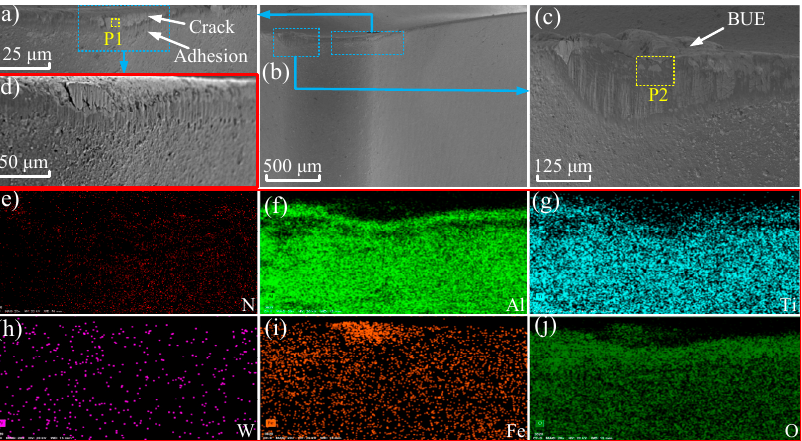
Figure 17. ( a – d ) The flank face wear of Tool A after 16 min of cutting. ( e – j ) Distribution of elements.